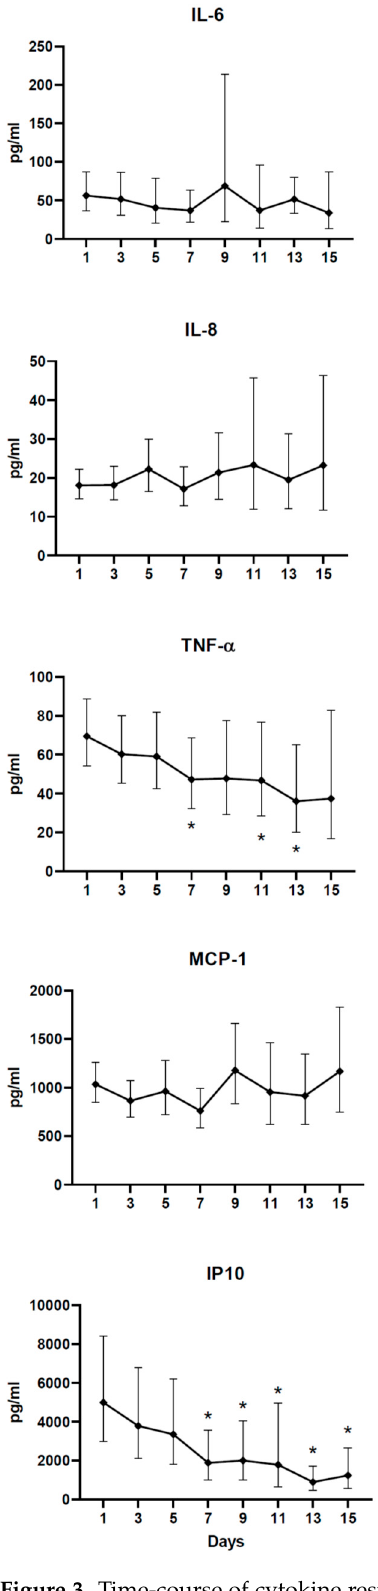
Figure 3. Time-course of cytokine response in COVID-19 patients after hospitalization. Cytokine concentrations of all patients in the study are shown as geometric mean with 95% CI. * indicates significant difference from day 1 values using paired t -test ( p < 0.01).